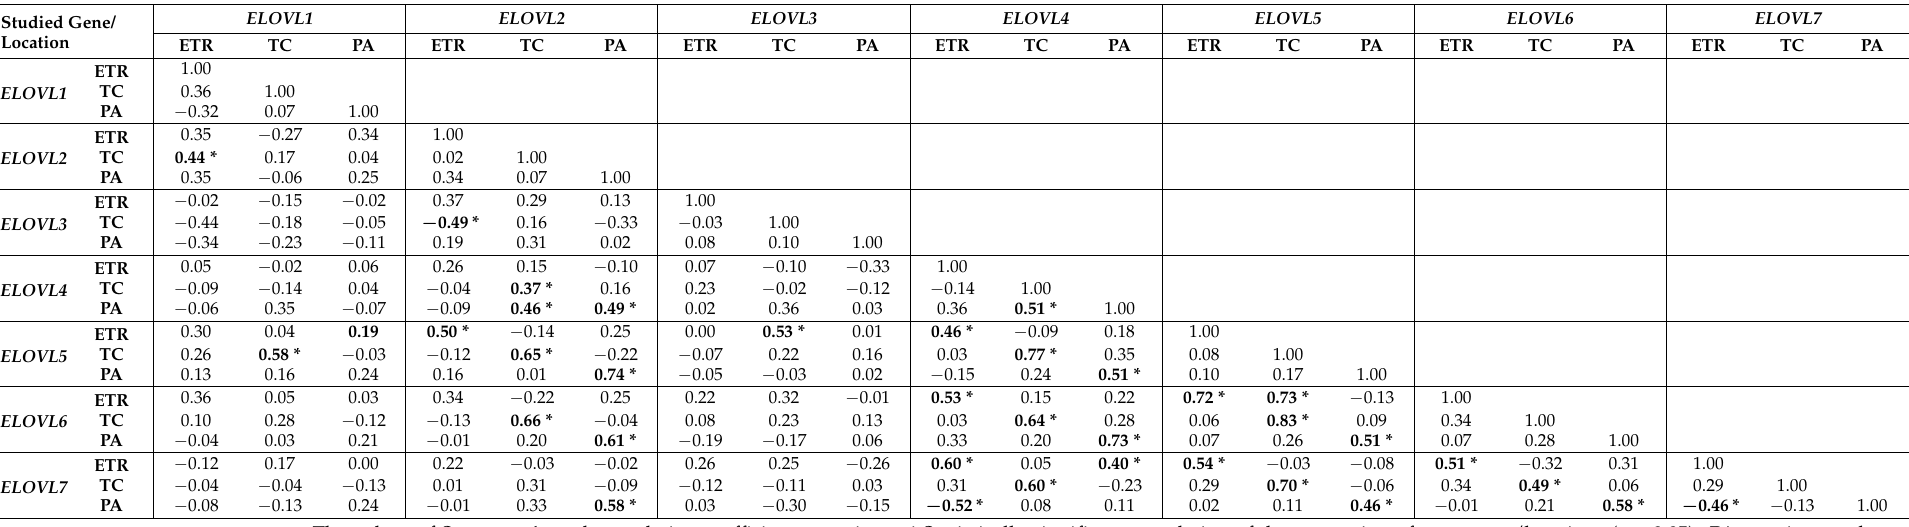
Table 2. Correlation of the expression of the studied elongases between each other and the studied GBM tumor regions. ELOVL1 ELOVL2 ELOVL3 ELOVL4 ELOVL5 ELOVL6 ELOVL7 Studied Gene/ Location